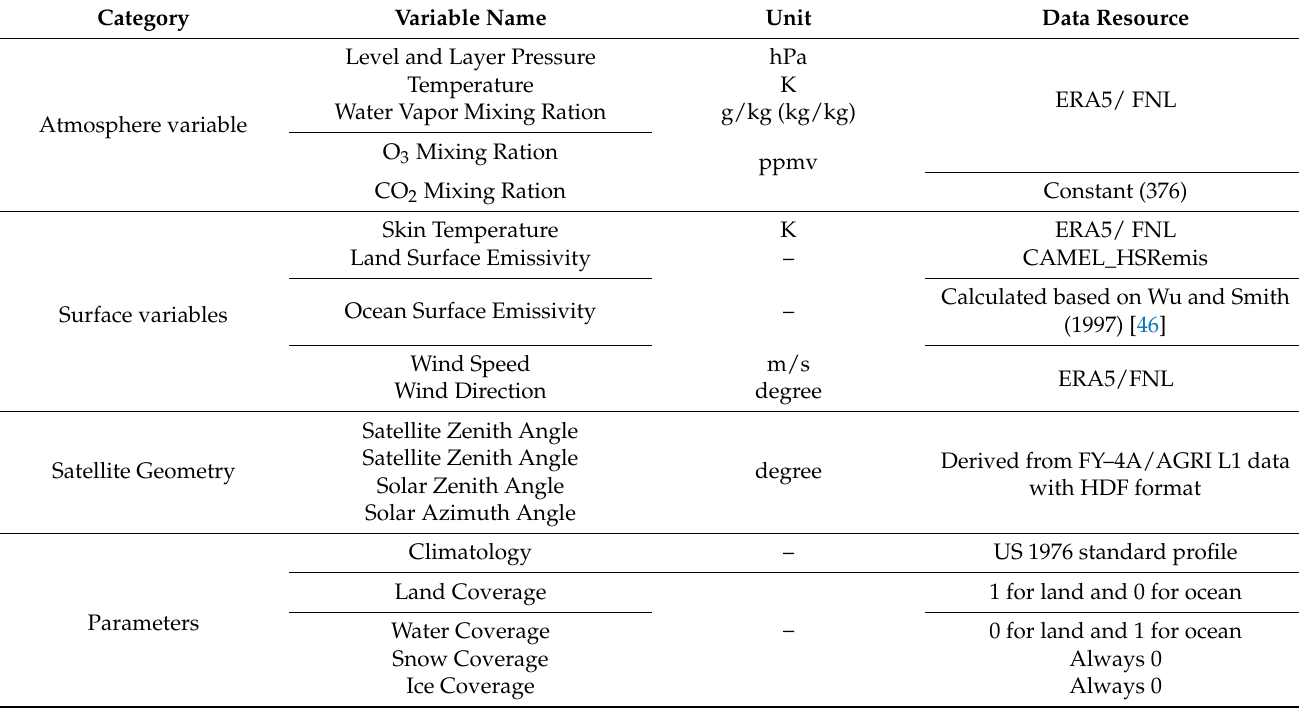
Table 2. Input variables and parameters for clear-sky simulations using ARMS or